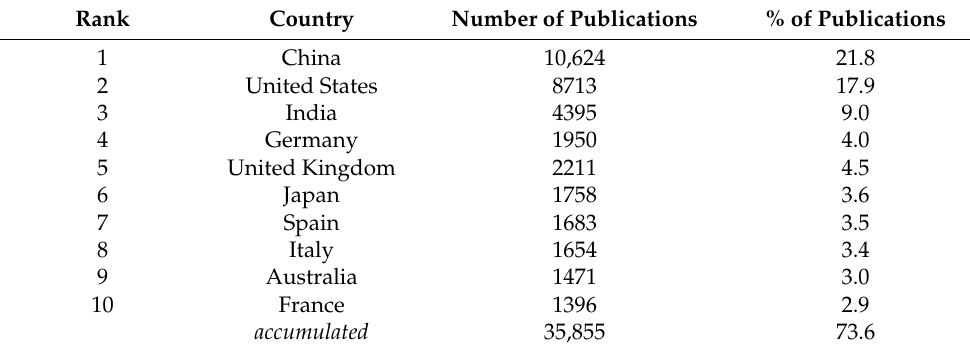
Table 1. Most productive countries in Solar Energy research (between 1900 and 2020).